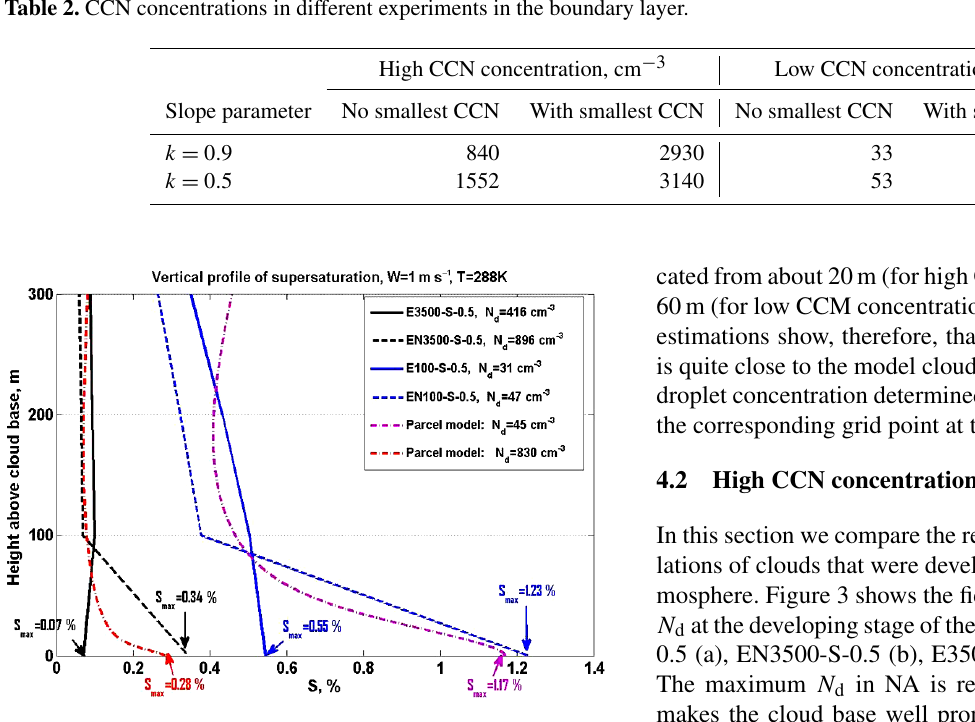
Figure 2. Examples of vertical profiles of the supersaturation above cloud base calculated using HUCM and a benchmark parcel model. The columns with w close to 1ms − 1 at cloud base were chosen for comparison. The values of S max in HUCM were calculated ac- cording to Pinsky et al. (2012). The values of droplets concentration calculated at cloud base in different simulations are shown as well (see legend